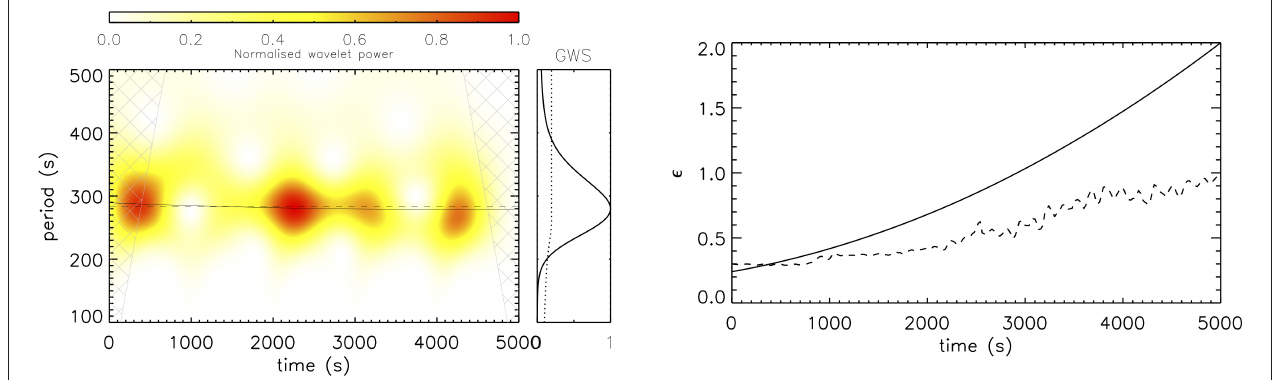
FIGURE 4 | Wavelet analysis of the loop oscillation (left panel). The solid line in the normalized wavelet power represents the fitted variation of the period of oscillation in time. The dashed line denotes the estimate based on the TTTB approximation. The hatched region represents the cone of influence. The global wavelet spectrum (GWS) is shown with the dotted line corresponding to the 90% significance level. The right panel shows the seismologically determined variation in inhomogeneous layer width (compared with the estimate in Figure 2 shown as a dashed